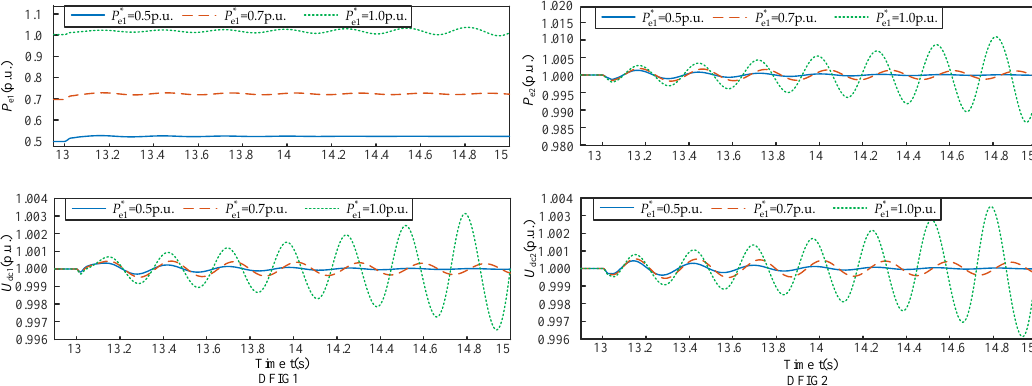
Figure 9. Active power outputs and DC-link voltages of the two-DFIG system for di ff erent active power outputs of DFIG1.